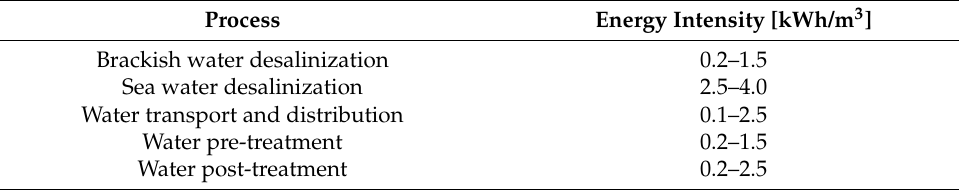
Table 9. Energy intensity for different stages in water production—U.S. case studies, after